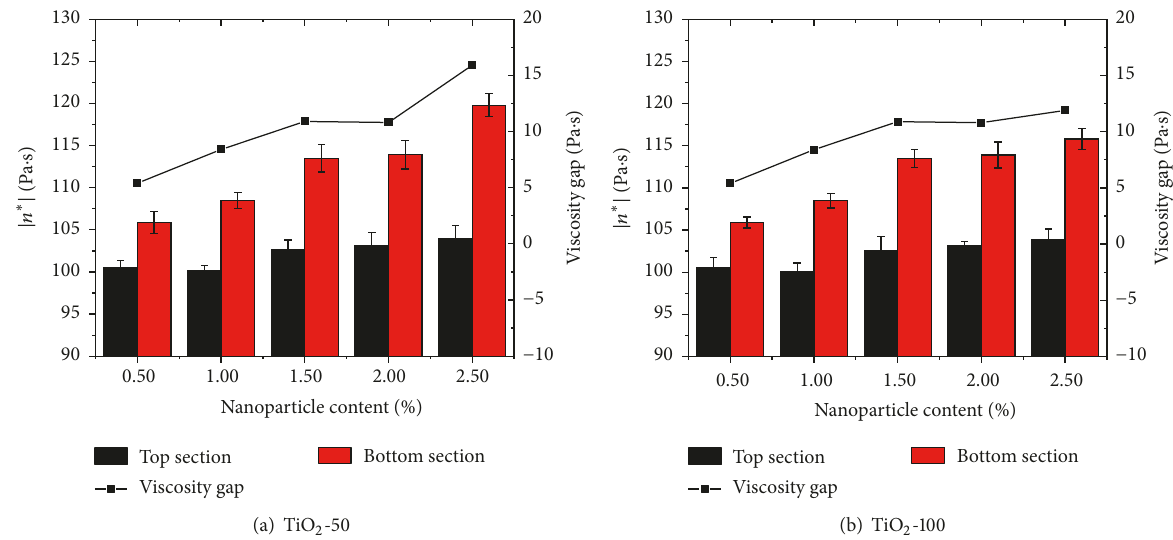
Figure 4: The effects of nanoparticle content on the dynamic-shear viscosity.